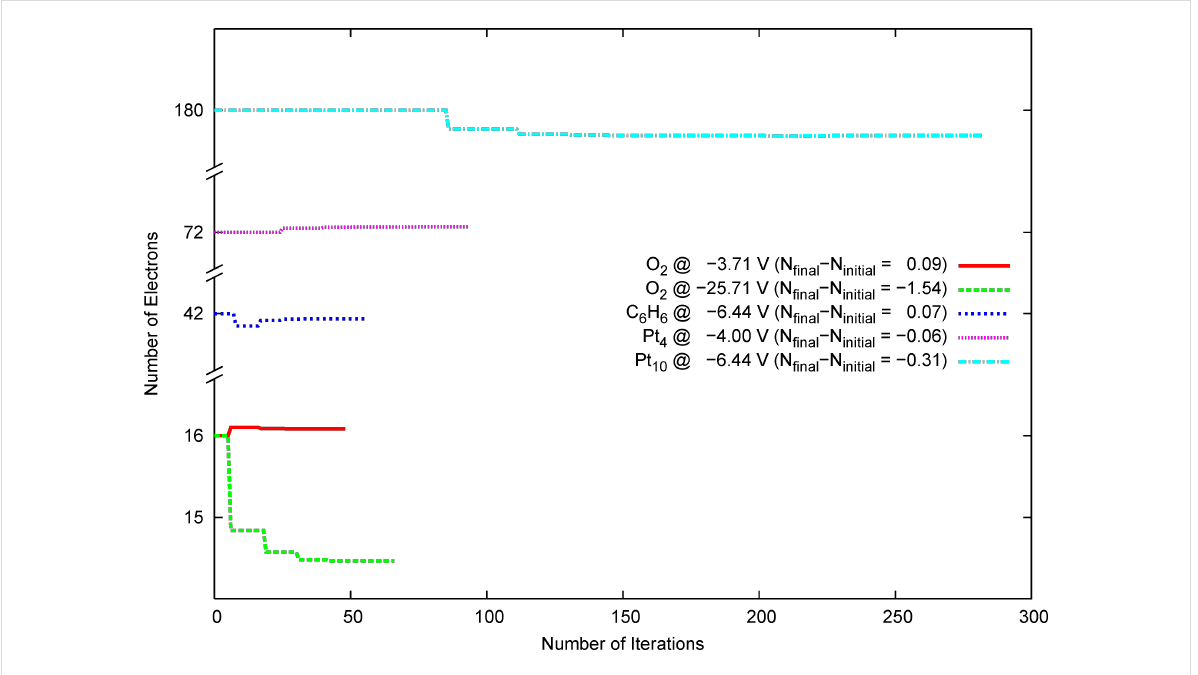
Figure 5: Convergence of the number of electrons with the SCF iterations for different systems. Note that the calculation for the charge neutral mole- cules with fixed number of electrons for O 2 converges within 7, for C 6 H 6 within 13, for Pt 4 within 73 and for Pt 10 within 177 SCF iterations, respective-